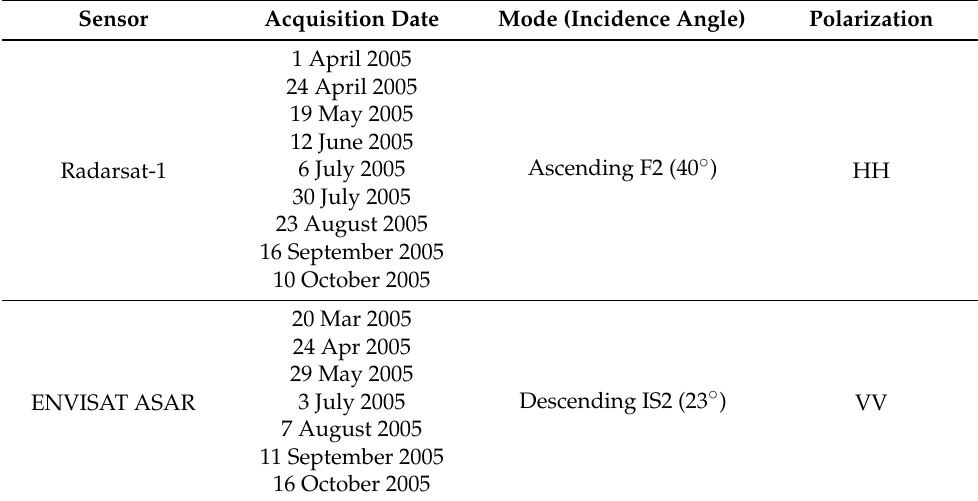
Table 1. List of SAR data sets used in this study.